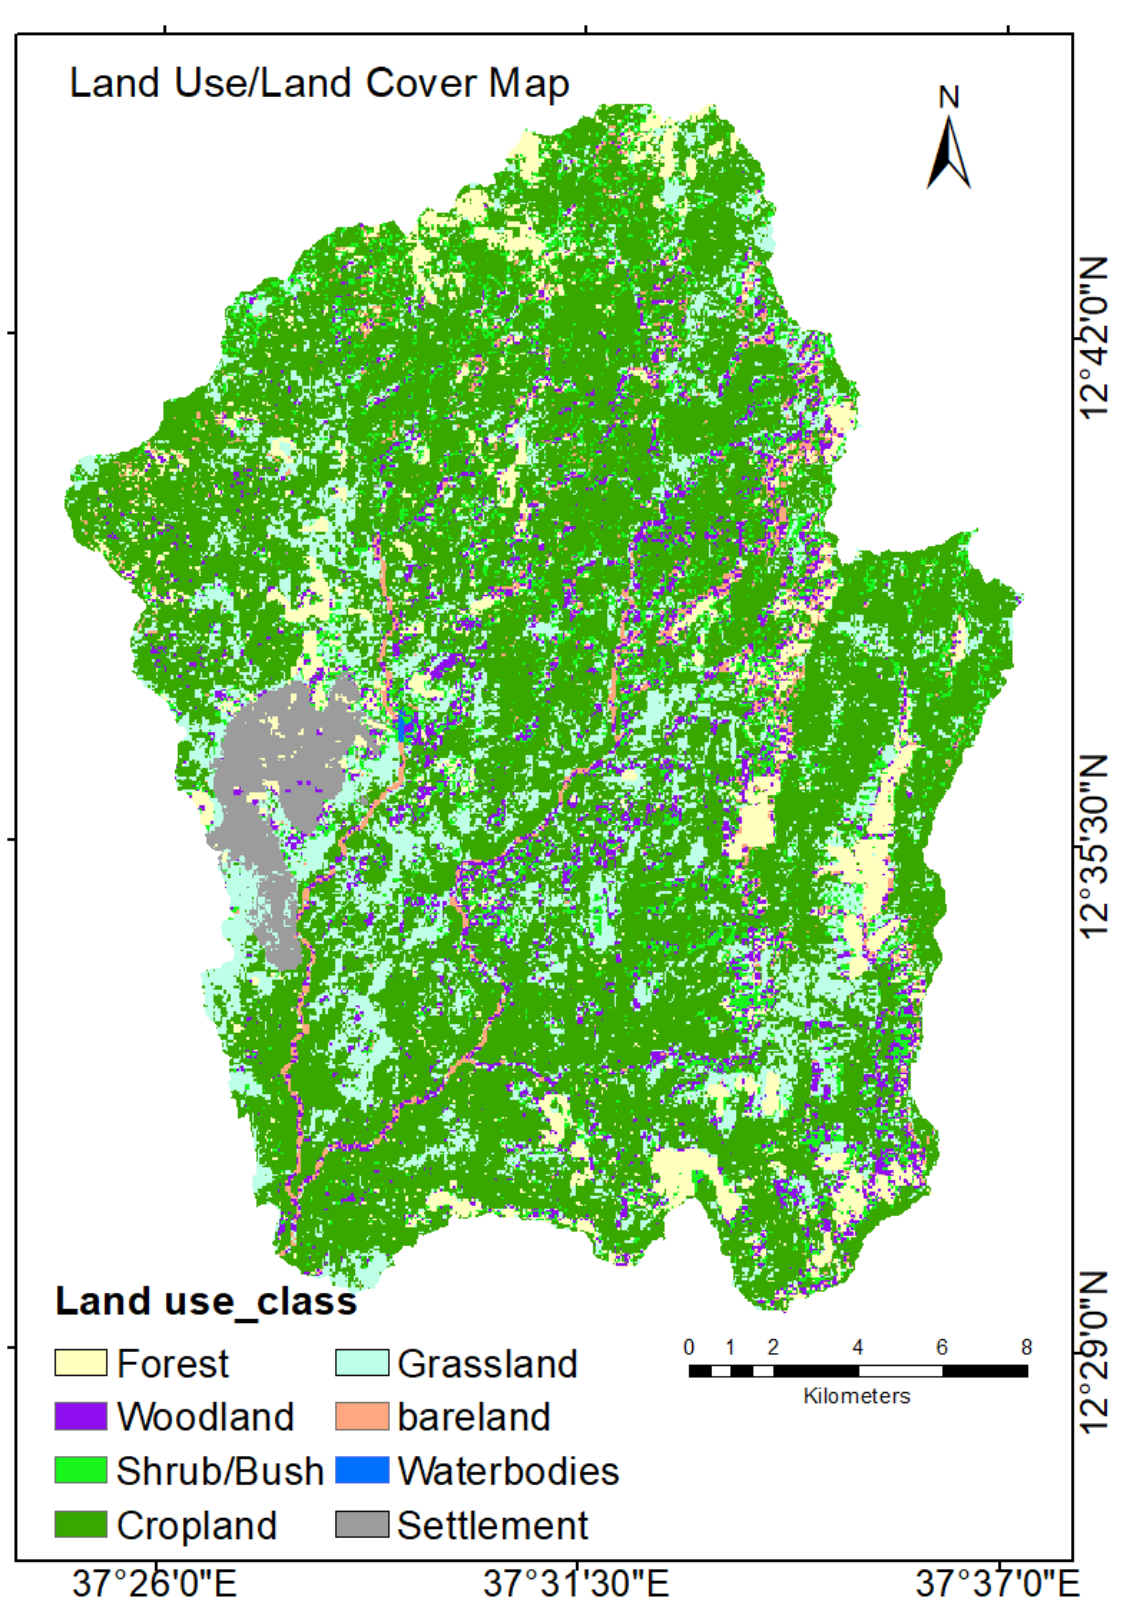
Figure 3. Land use land cover map for the Megech watershed.